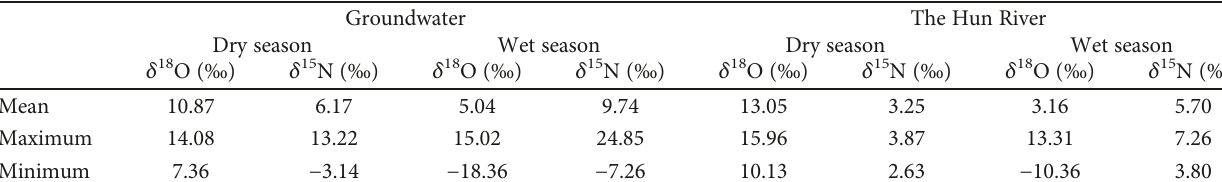
( ‰ ) and δ 15 N ( ‰ ) values of groundwater and river water in the study area. nitrate nitrate Groundwater